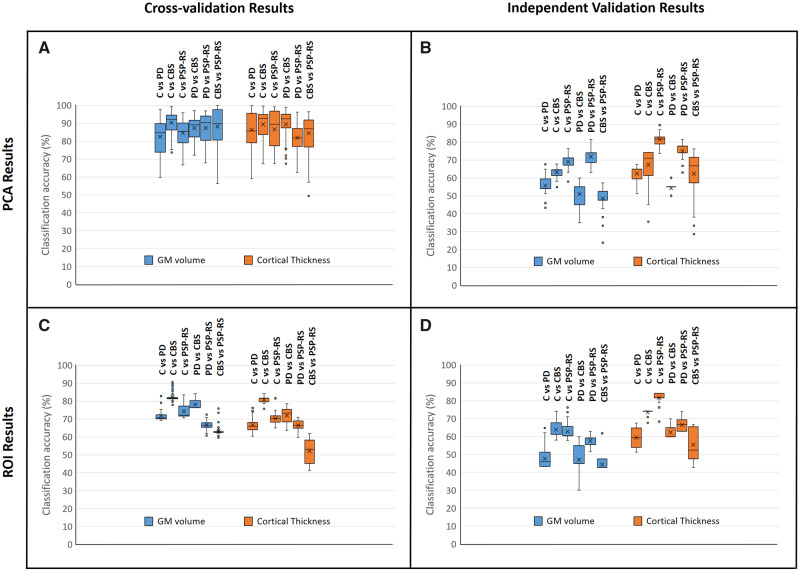

GM volume versus cortical thickness. Comparison between GM volume (blue) and cortical thickness (orange) as feature types. The range of classification accuracies presented for each pairwise comparison and combination of methodological variables corresponds to the results obtained as different numbers of features are included in the statistical model. (A) Cross-validation results when PCA is used for feature extraction. (B) Independent validation results when PCA is used for feature extraction. (C) Cross-validation results when ROIs are used for feature extraction. (D) Independent validation results when ROIs are used for feature extraction.